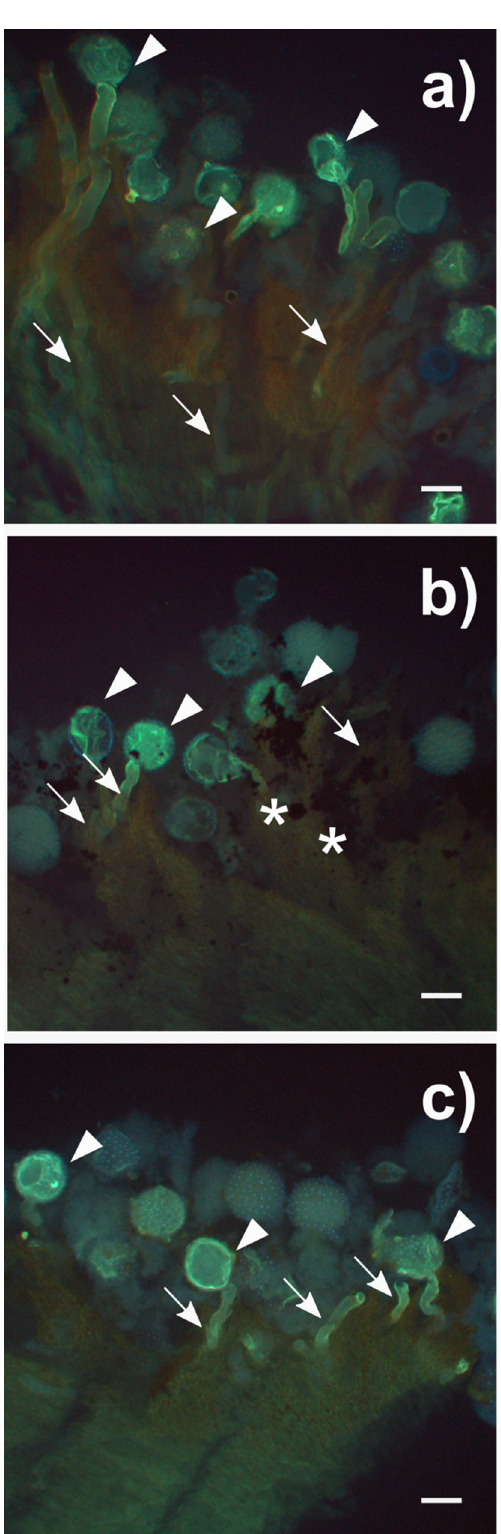
Figure 4. ( a ) Fluorescence micrographs of stigmatic surfaces of hand-pollinated Cucurbita pepo L. female flowers treated for three hours without nanomaterials (CTRL); ( b ) with 1 mg of few-layer graphene (FLG); ( c ) with 1 mg of muscovite mica (MICA). Aniline blue staining protocol was applied 40 min after pollination (for more details, see text). Pollen tubes are indicated with arrows, pollen grain with arrowheads, and FLG with asterisks. Bars = 100 µm.